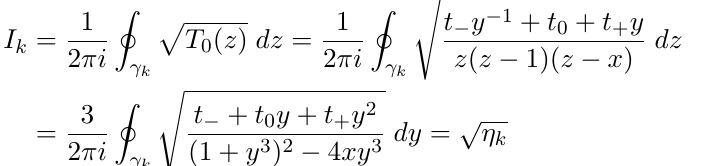
(1 + e (cid:6) i(cid:18) ) mapping to y = u k ; v k , 2